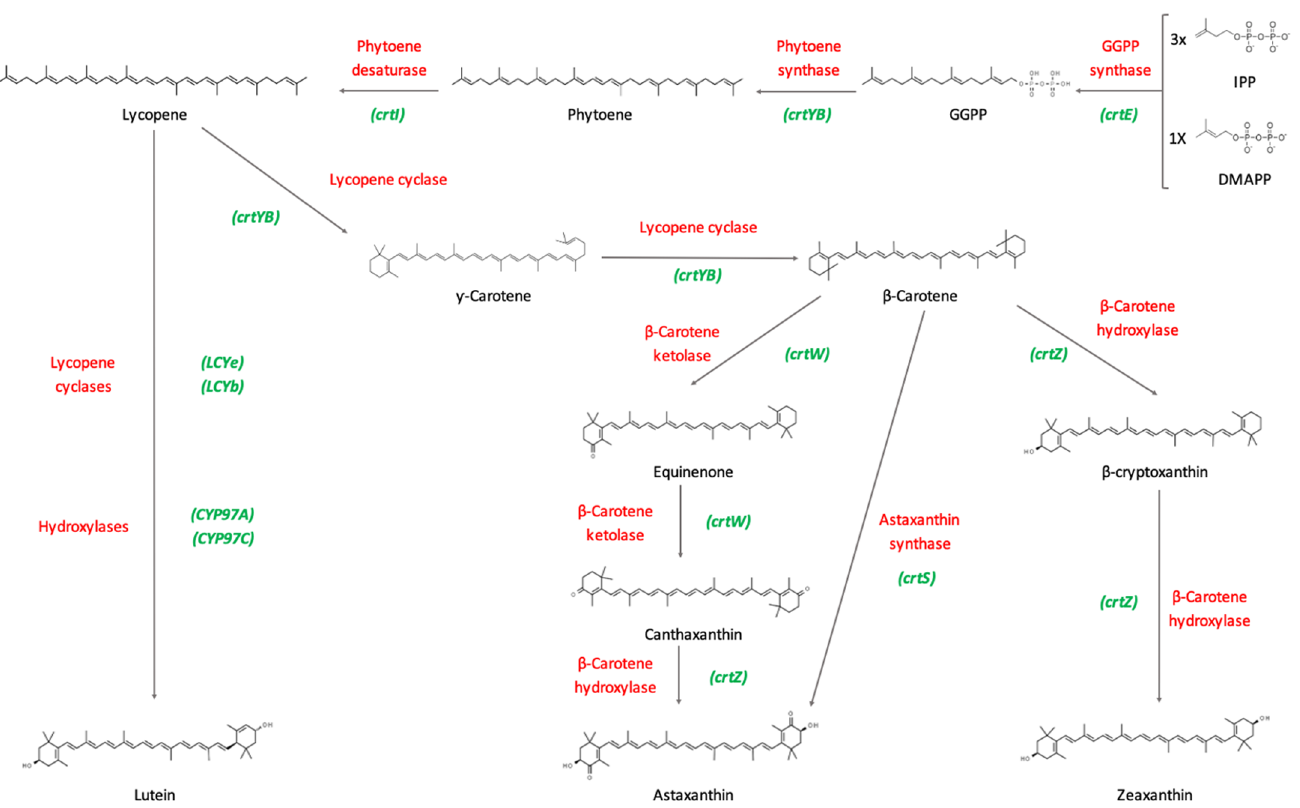
Figure 3. Biosynthetic pathway of main commercial carotenoids. The pathway begins with the condensation of three molecules of isopentenyl pyrophosphate (IPP) and one molecule of dimethylallyl pyrophosphate (DMAPP) by means of the enzyme GGPP synthase ( crtE ), forming geranylgeranyl diphosphate (GGPP). In some fungi, such as X. dendrorhous , the gene crtYB encodes for a bifunctional enzyme that can perform as a phytoene synthase and as a lycopene cyclase, it combines two molecules of GGPP forming phytoene. Afterwards, phytoene is transformed into lycopene by means of the enzyme phytoene desaturase ( crtI ). The enzyme encoded by the gene crtYB , and with its lycopene cyclase activity, is able to convert the acyclic ends of lycopene to β -ring, and to generate carotenoid diversity, by producing β -carotene and γ -carotene. Further ketolation and hydroxylation reactions synthesize the rest of carotenoids. Lutein can be synthesized from lycopene through the action of two lycopene cyclases (LCYe and LCYb) and two hydroxylases (CYP97A and CYP97C). Red color indicates the enzyme name, whereas green color shows the gene names. This figure is based on Rodríguez-Sáiz and co-workers and Barreiro and co-workers [8,39].